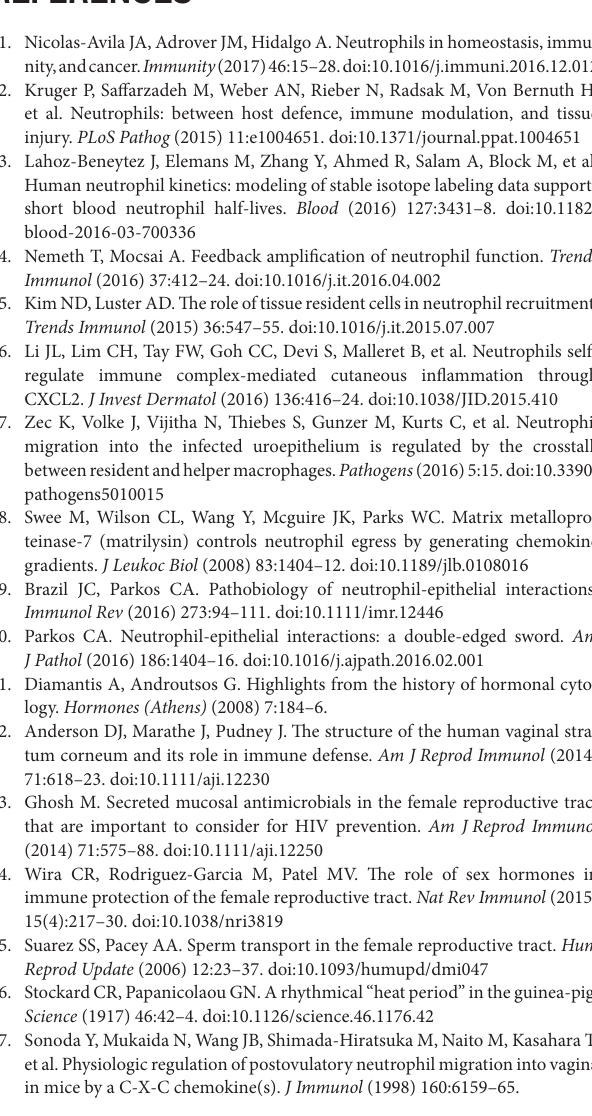
FigUre s1 | Representative flow cytometry plots of PMN purification analysis by flow citometry. Representative dot plots of cells stained with CD16 and CD3 to assay purity and 7AAD as a marker of cell death. A representative experiment of three independent tests is shown. FigUre s2 | Hormone-treated ovariectomized mice were mock or Candida albicans inoculated in the vagina. (a) Female reproductive tract (FRT) indicated